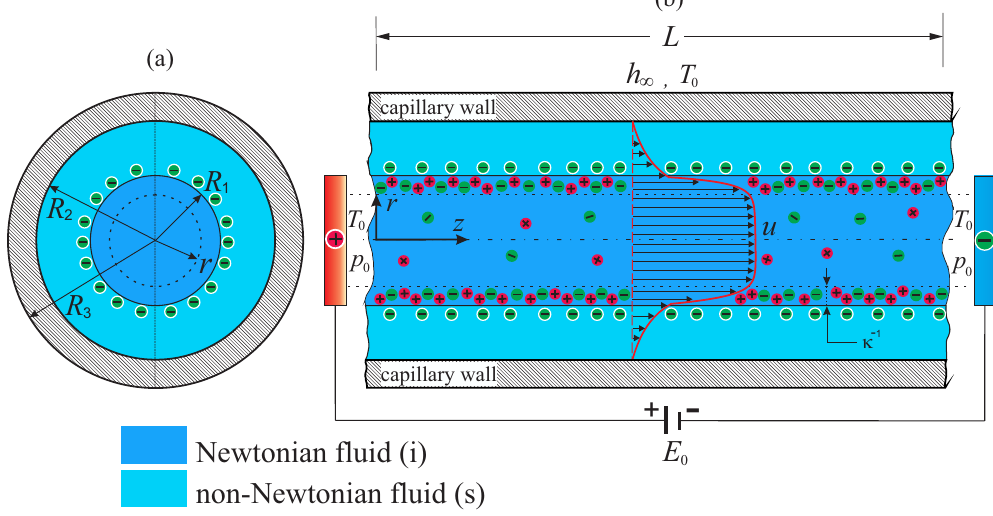
Figure 1. (Color online) Schematic of the electroosmotic flow of two immiscible fluids in a microcapillary: ( a ) cross-sectional view and ( b ) side view, depicting both fluids in distinct